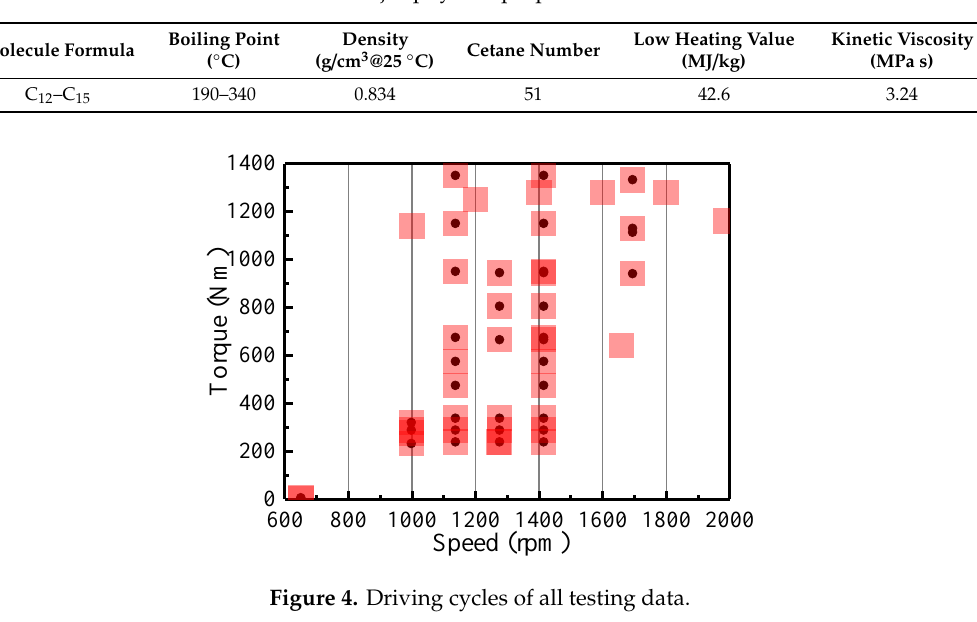
Table 2. Major physical properties of diesel.